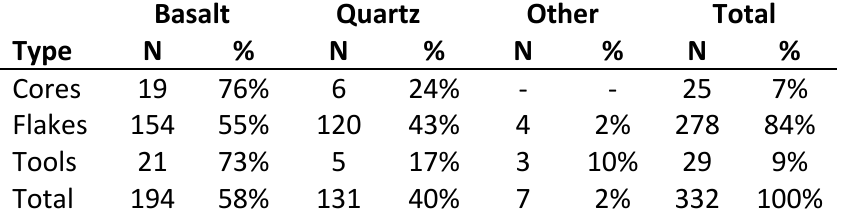
Table 1. Lithic assemblage in basalt and quartz from GOT 1-S.